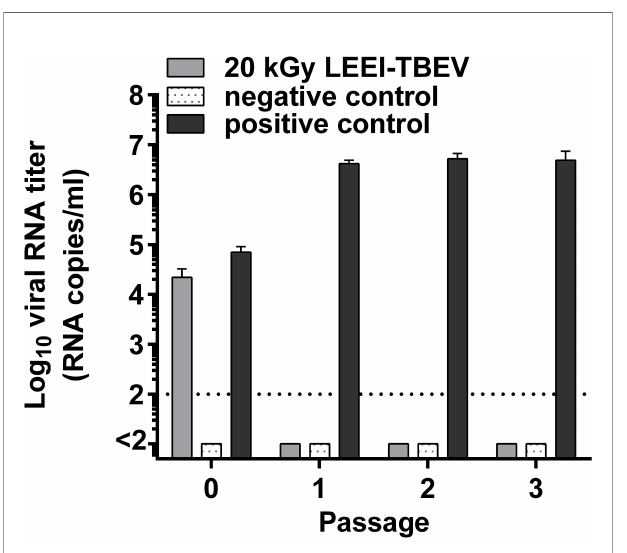
FIGURE 1 | Con fi rmation of inactivation of LEEI-TBEV samples used for mice immunization. Virus inactivation was performed using a LEEI dose of 20 kGy. Samples were transferred in triplicates to BHK-21 cells and after 3 days the supernatant was passaged onto fresh cells, followed by another passage three days later. Negative control= mock-infected cells; positive control= active TBEV undergoing the LEEI process without irradiation; P0 samples collected at 1 hour post-inoculation; P1= supernatant collected 3 days after inoculation; P2= supernatant collected 3 days after the fi rst passage; P3= supernatant collected 3 days after the second passage. Collected cell culture supernatants were analyzed for TBEV RNA by RT-qPCR. Shown are mean values of triplicates ± standard deviations. The dotted line indicates the limit of detection (100 viral RNA